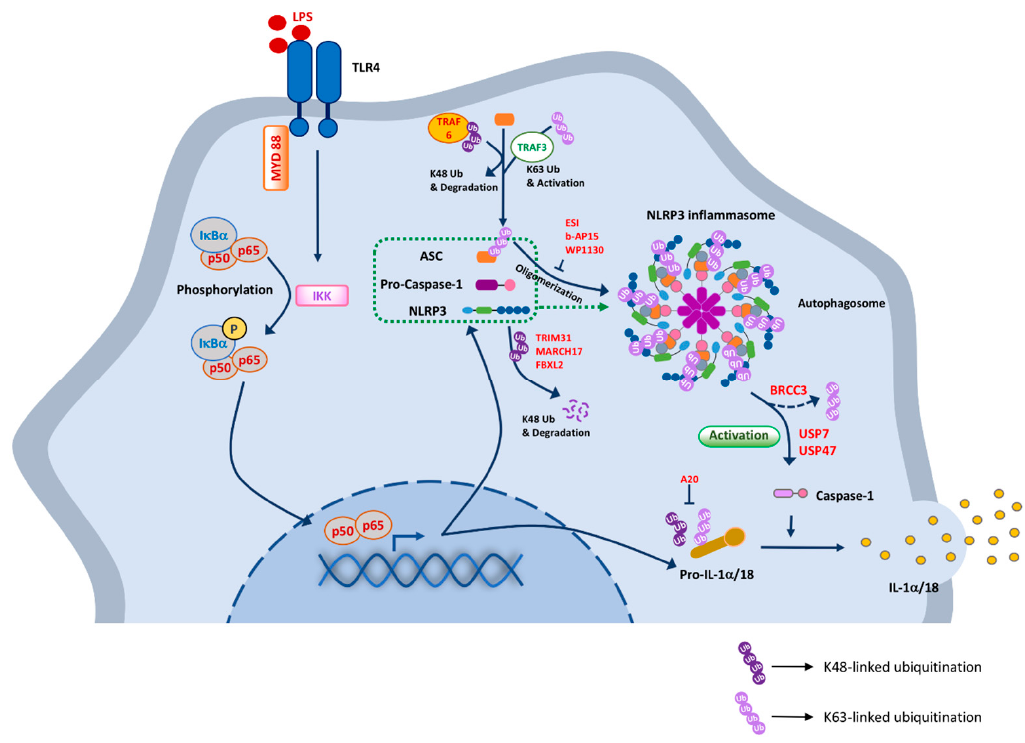
Figure 2. Schematic diagram of the mechanism of NLRP3 inflammasome activation by ubiquitination in macrophages. Inflammasome requires a priming signal, such as LPS, that activates the NF- κ B subunits (p50 and p65), leading to upregulation of pro-IL-1 β / IL-18 and NLRP3 genes in macrophages. Activation signals, such as ATP and bacterial toxins, increase potassium influx, which recruits ASC and Caspase-1 to assemble the active NLRP3 inflammasome complex. Caspase-1 generated by active NLRP3 inflammasome cleaves and secretes proinflammatory cytokines such as IL-1 β and IL-18. Dark purple circles indicated K48-linked ubiquitination and light purple circles indicate K63-linked ubiquitination. The details of how specific DUBs and DUB inhibitors regulate the activities of the NLRP3 inflammasome signaling molecules are described in the